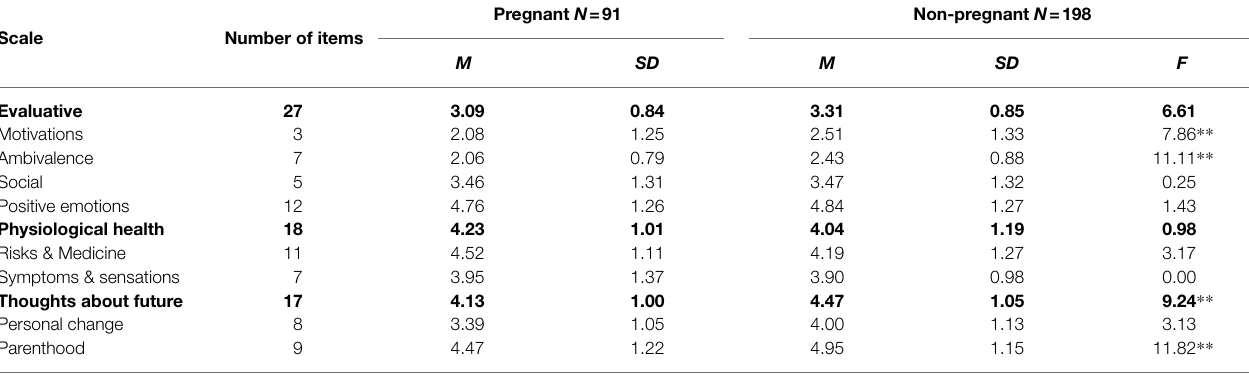
TABLE 4 | Means, standard deviations, and F-scores of the scale scores for pregnant and non-pregnant participants.